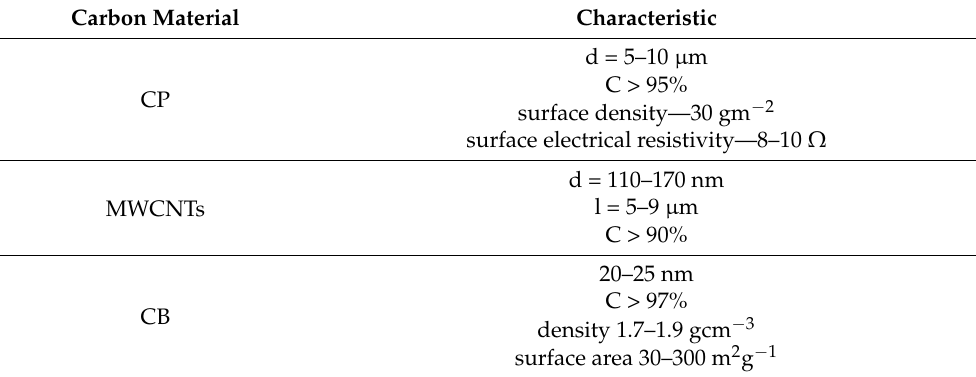
Table 1. Characteristics of carbon materials used for studies.